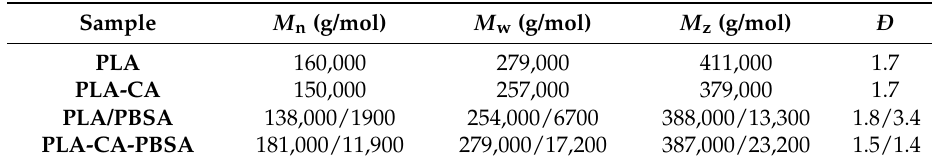
Table 1. Number average molecular weight ( M n ), weight average molecular weight ( M w ), z-average molecular weight ( M z ) and polydispersity index ( Ð ) of the different PLA films.